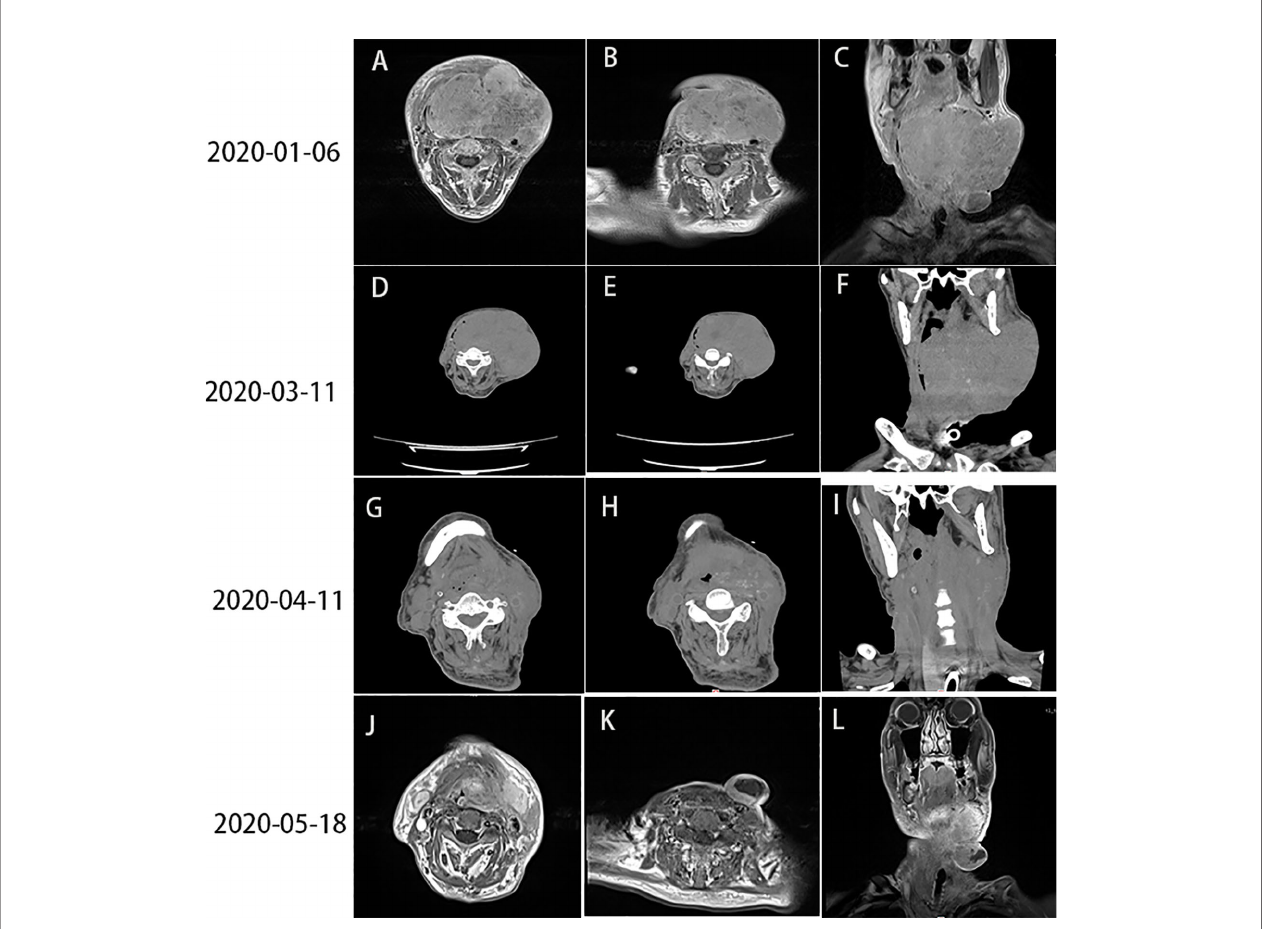
FIGURE 1 | (A – C) Head and neck CT showed lymph node enlargement (10 × 12 cm) on the left side of the neck (January 6, 2020). (D – F) Head and neck CT, performed 10 days after the fi rst cycle of treatment, showed progression of the tumor mass (13 × 10 cm) (March 11, 2020). (G – I) PR was detected after the fi rst course of combination therapy with sintilimab and nimotuzumab (April 11, 2020). (J – L) Head and neck MRI revealed PR (May 18, 2020). CT, computed tomography; MRI, magnetic resonance imaging; PR, partial